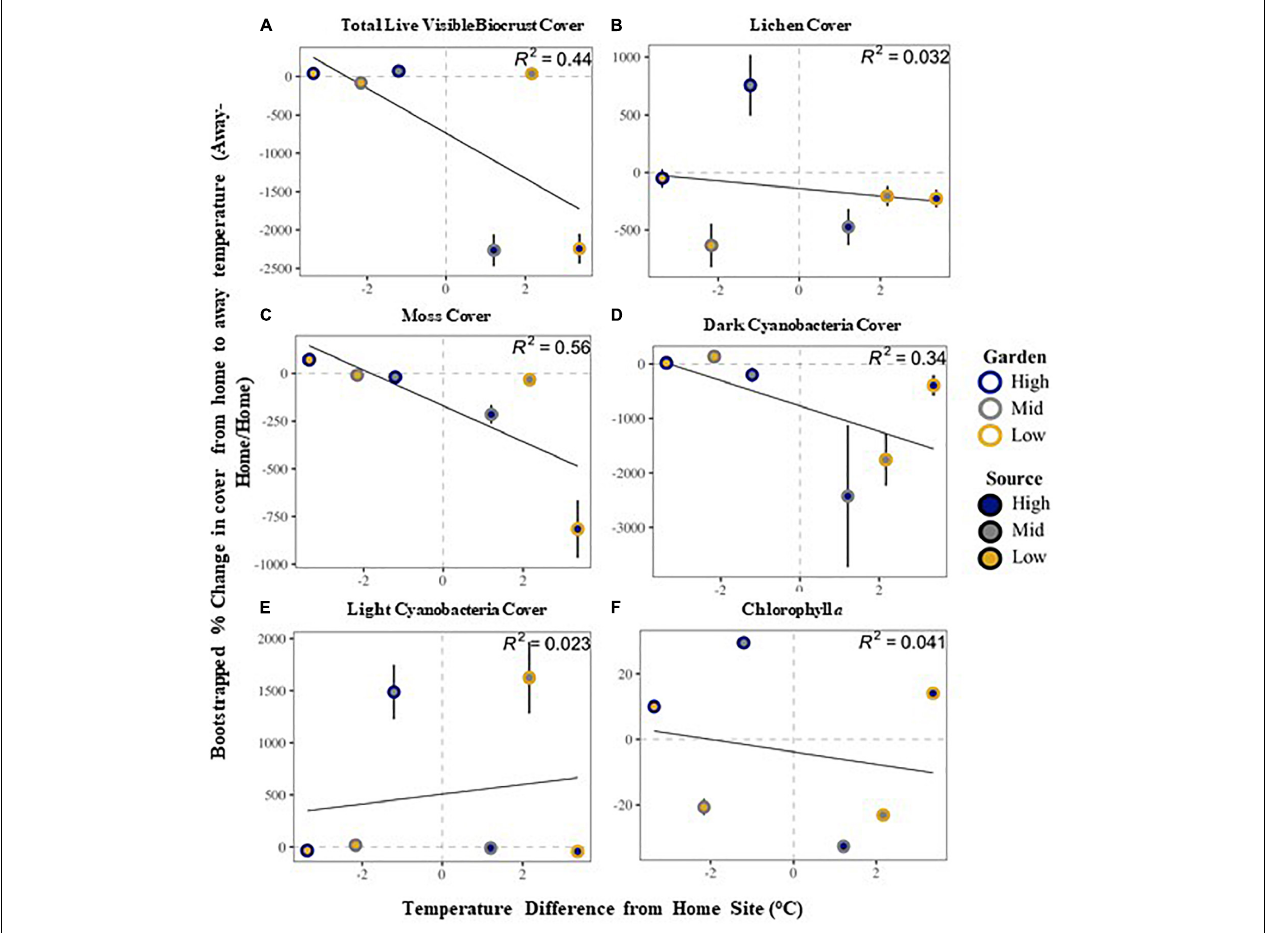
FIGURE 3 | Relationship between visible biocrust cover compositional change from home source to away source based on home-away temperature differences: total live biocrust visible cover (A) , lichen cover (B) , moss cover (C) , dark cyanobacteria cover (D) , light cyanobacteria cover (E) and chlorophyll a (F) . See text in methods for the specific calculations. The solid line is a regression linear fit line representing the difference in temperature from the home site in relationship to the change in cover. The R 2 -value is given in the corner of each panel. Dashed line is at zero, and values above that line show an increase, whereas values below demonstrate a decrease. Error bars are bootstrapped standard